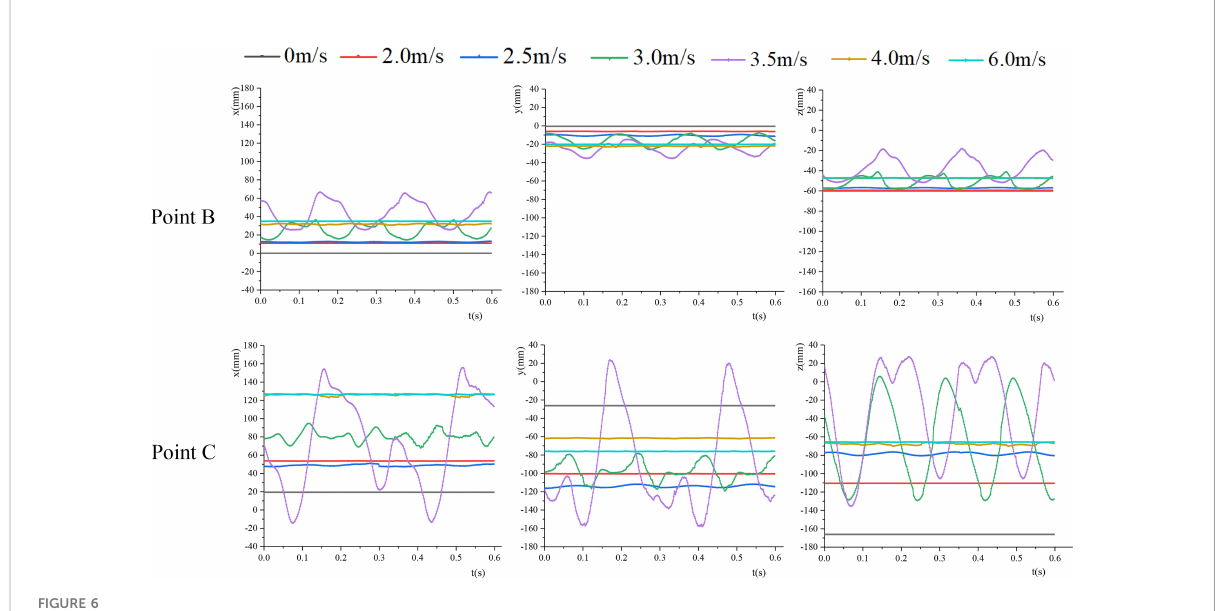
FIGURE 6 The coordinate changes of points B and C in each